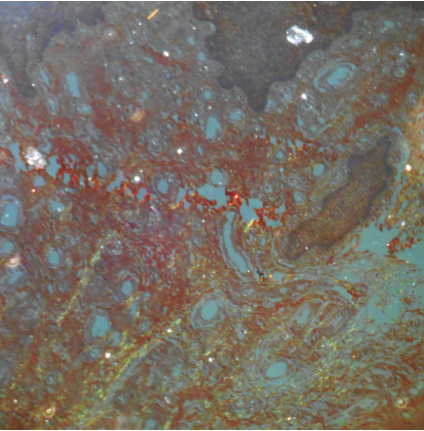
Figure 6: Congo red staining was negative.